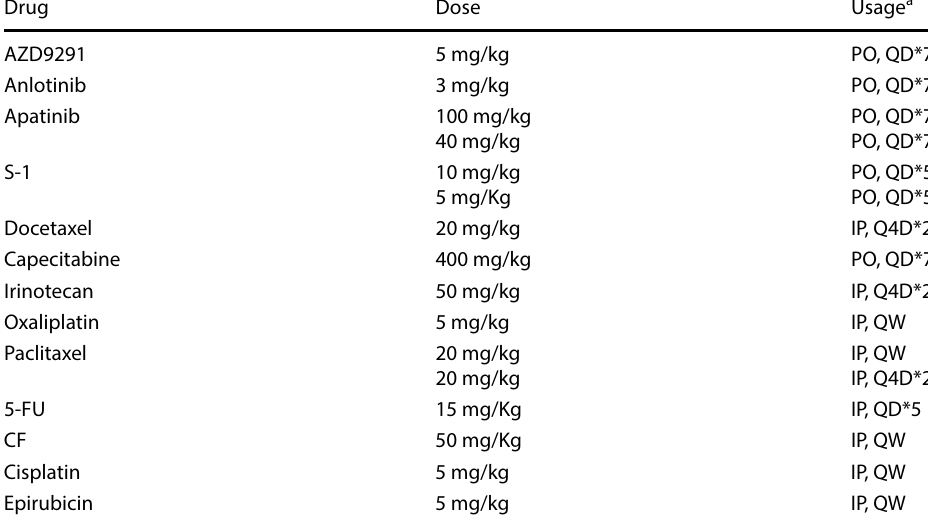
Table 1 Drug preparations and treatment